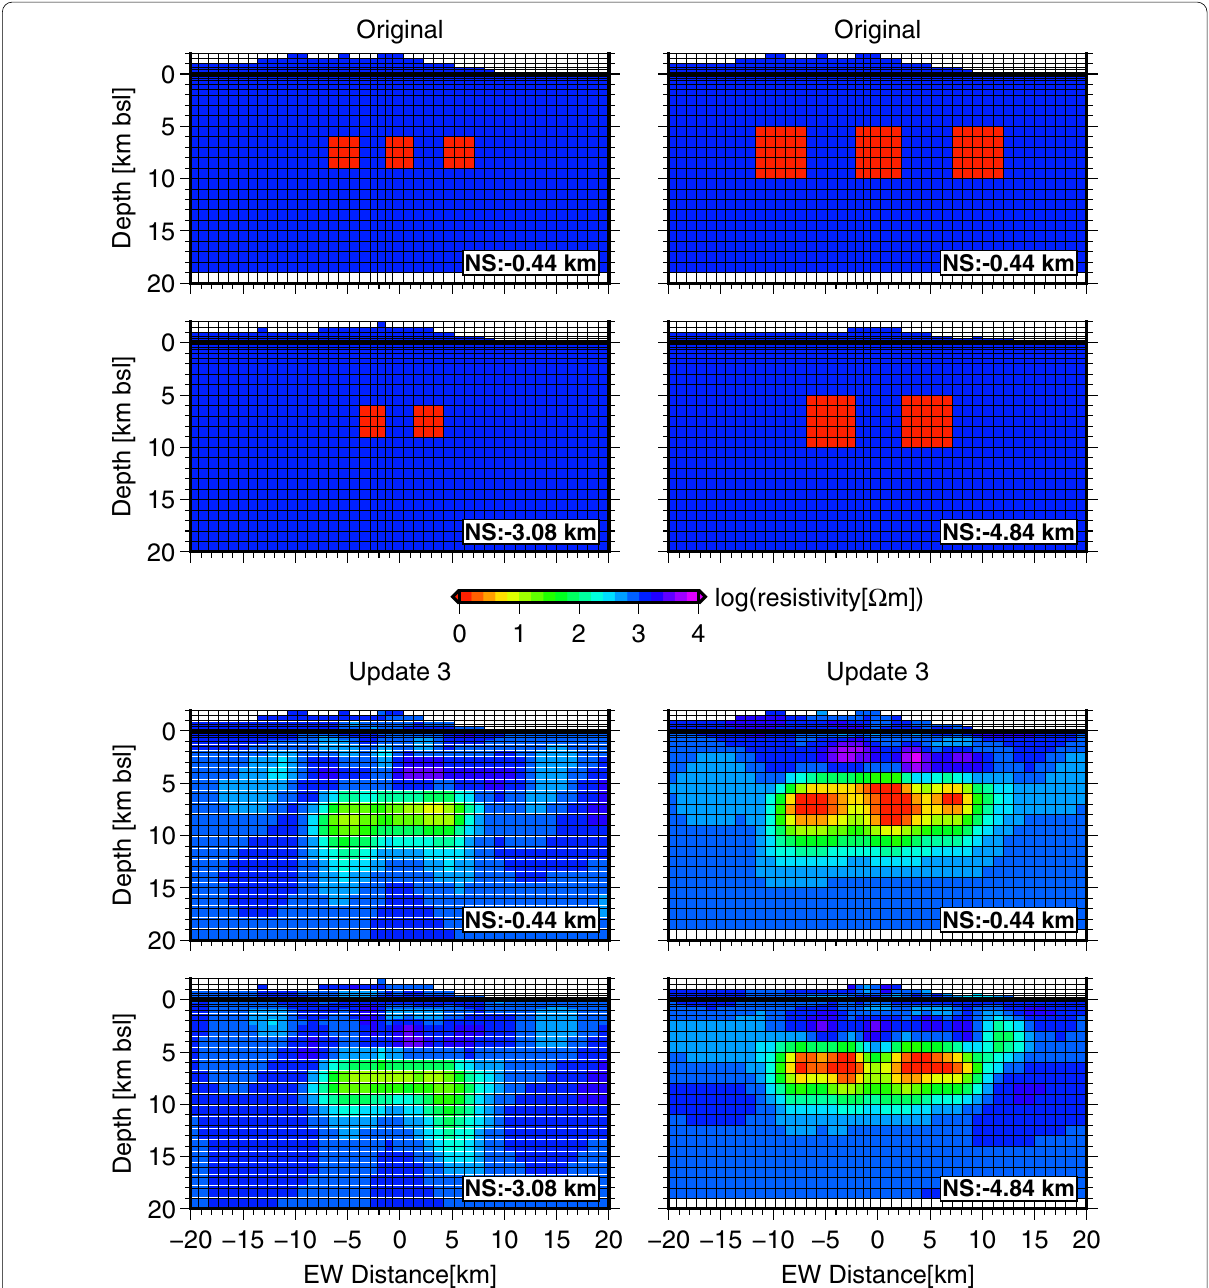
Fig. 12 Vertical profile in the E–W direction of CRT input and output models. The left and right columns represent the models using checkerboxes with one side 3 and 5 km,